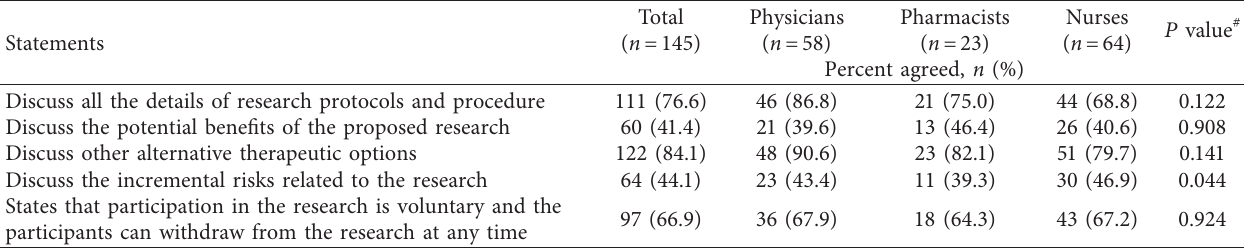
Table 4: Healthcare provider’s awareness about the information that should be discussed during proxy consent process ( n � 145).